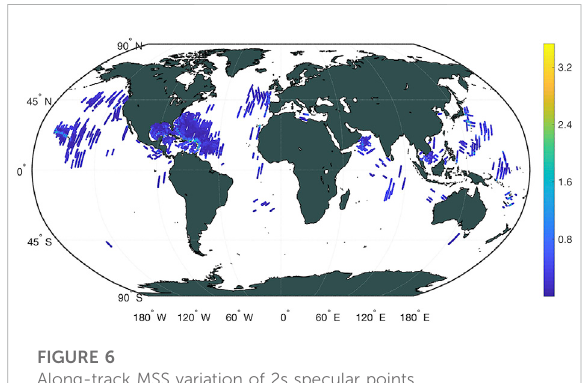
FIGURE 6 Along-track MSS variation of 2s specular